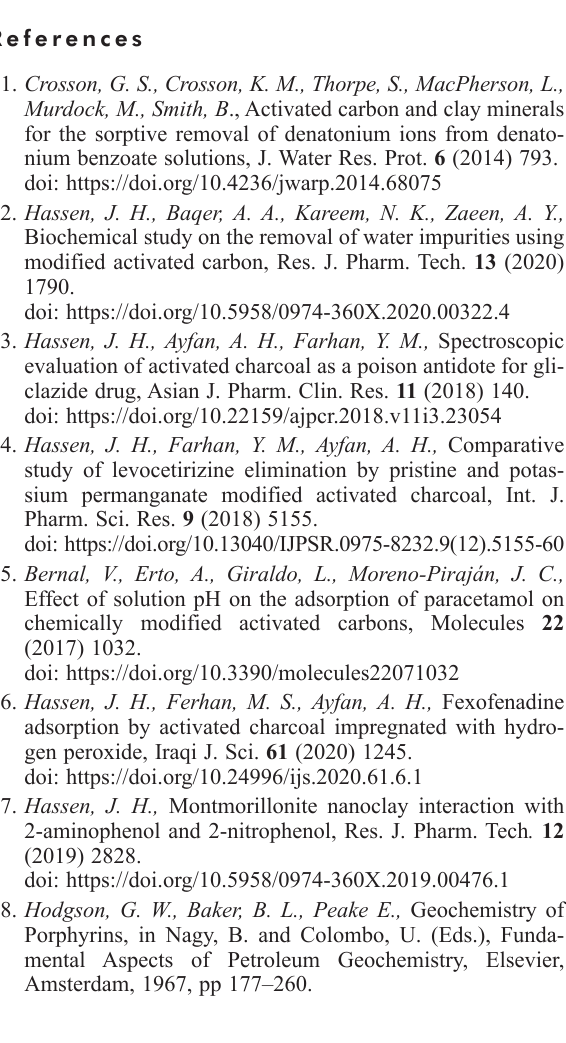
Fig. 5 – Schematic presentation of the orientation of the por- phyrin molecule in MMT interlayer